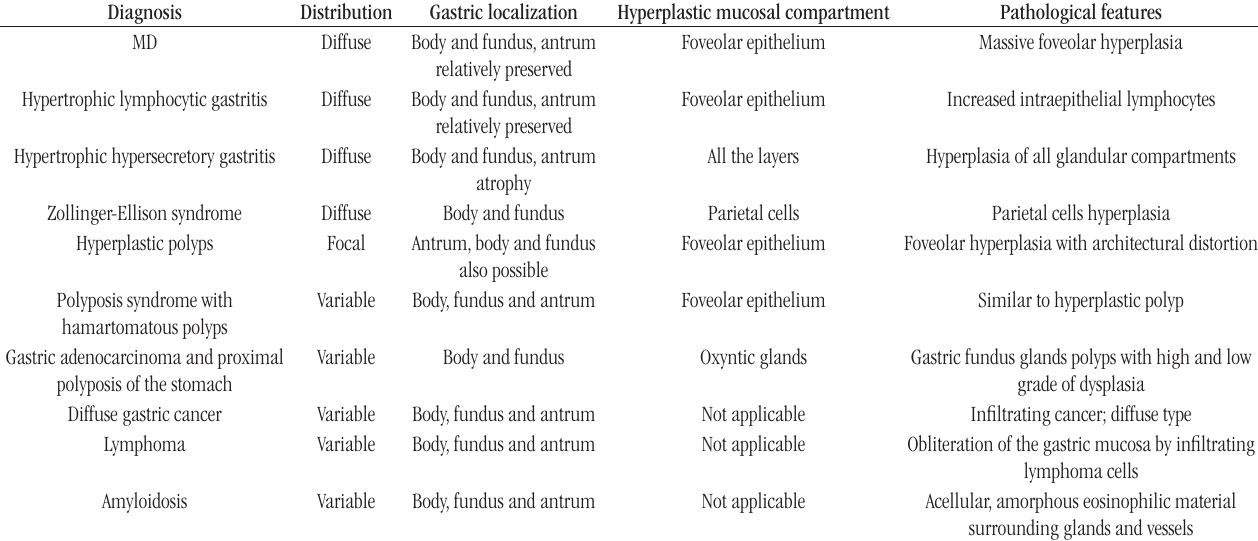
taBLE − Differential diagnostics for